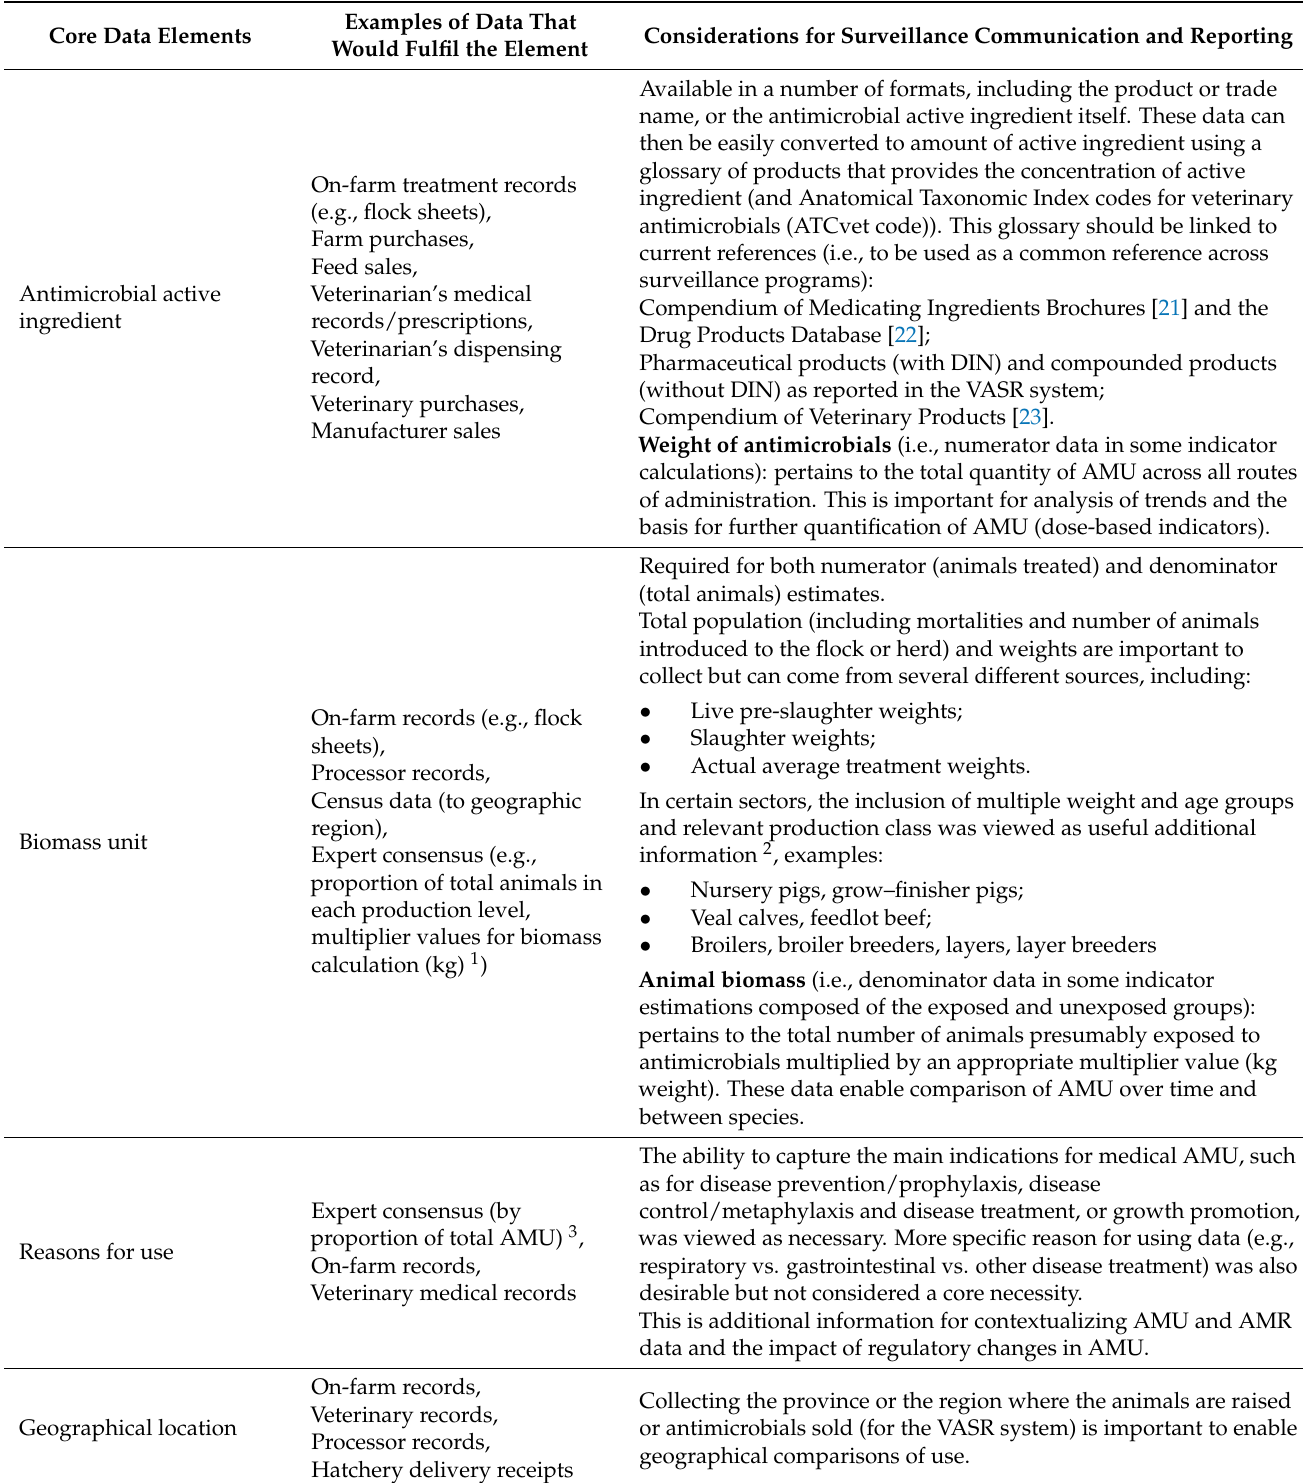
Table 1. Core elements of minimum dataset for antimicrobial use surveillance and considerations for